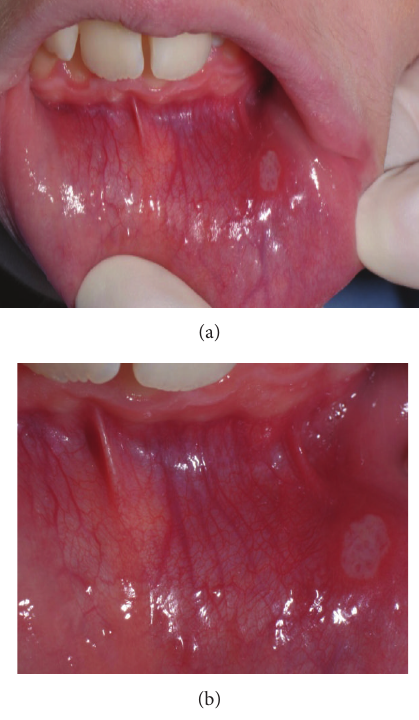
Figure 2: Mucosal aphthous stomatitis in an ascertained coeliac patient (A Group).